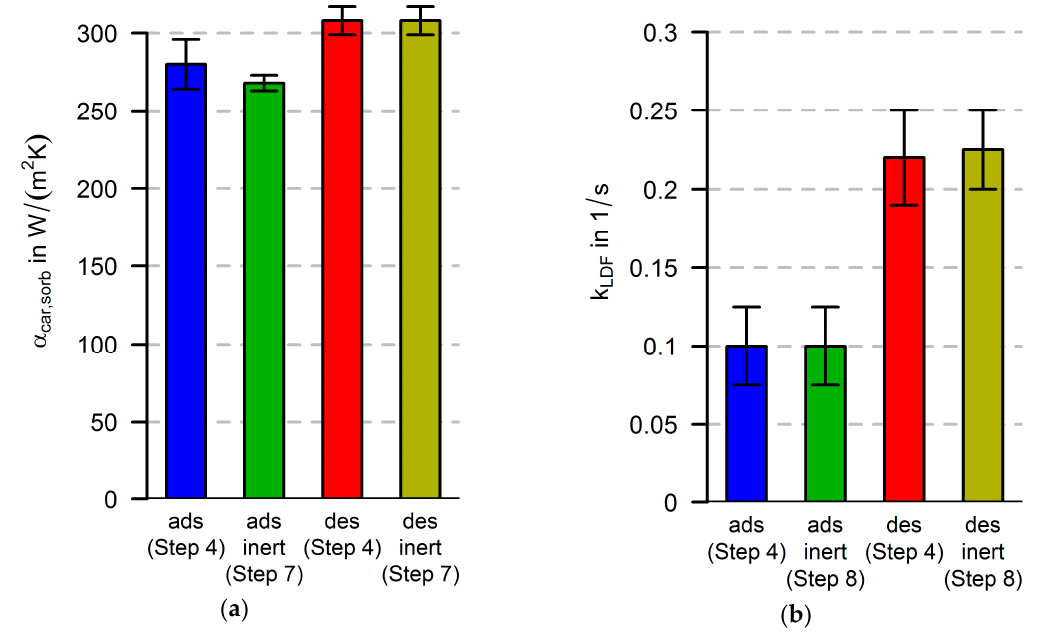
Figure 6. Identified heat transfer parameter ( a ) and mass transfer parameter ( b ) for adsorption (ads) and desorption (des) measurements of sample 3_Sio. The results labelled with “inert” are based on the newly-introduced inert-LTJ measurements. These data are also listed in Tables 7 and 8. The labelling of the x-axis includes the number of the corresponding step in the measurement and simulation procedure in Figure 4. For all given parameters, the best fit for both the p- and T-signal was selected. This is the minimum of the objective function in Equation (21) for equal weights ξ p and ξ T .